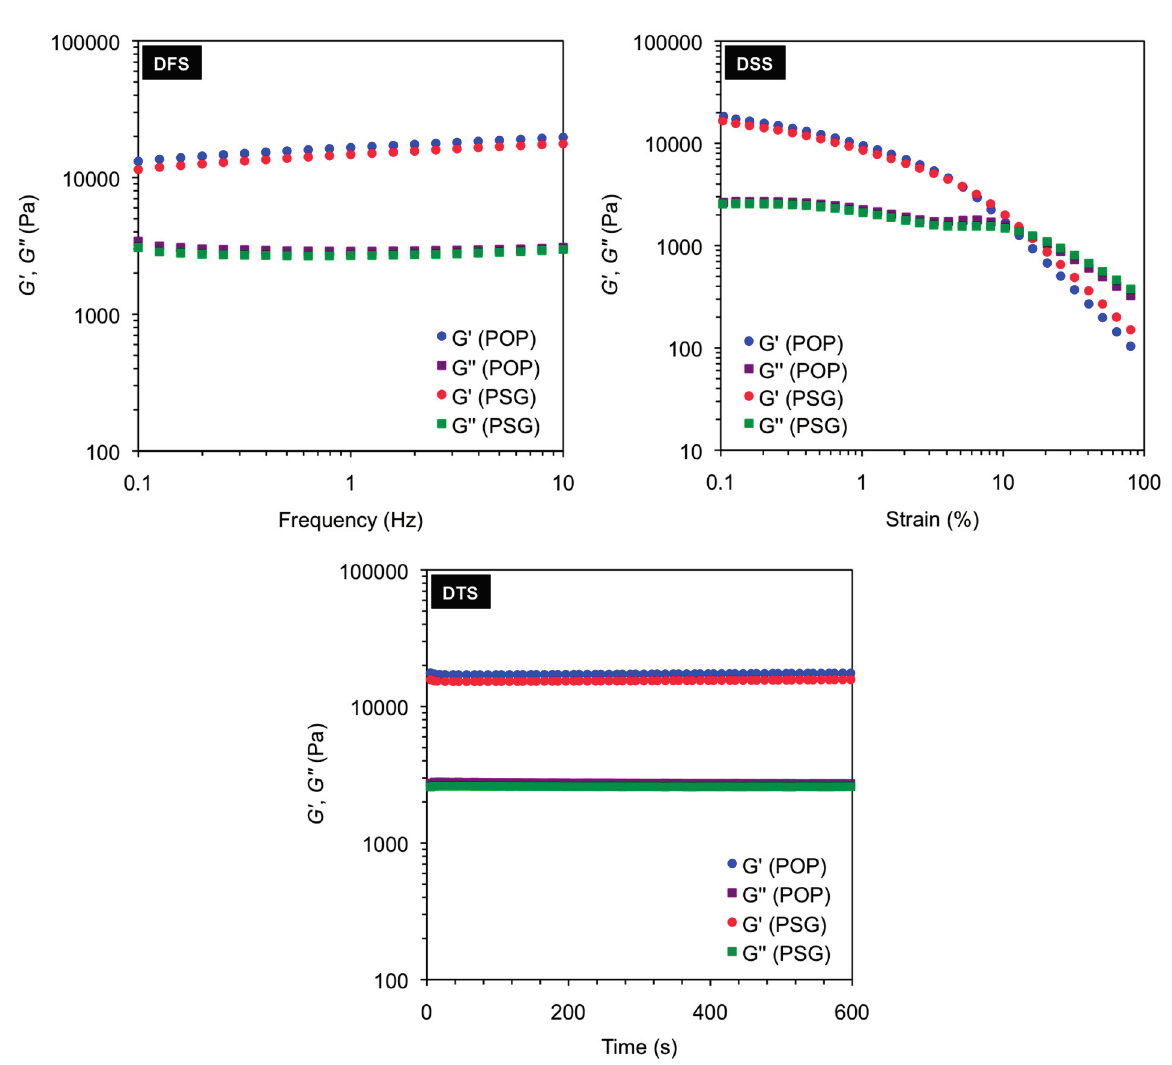
Figure 2. Dynamic oscillatory rheological measurements ( i.e. , DFS, DSS, DTS) of the gels in toluene obtained after gelation of pure organic phase (POP) and phase selective gelation (PSG) of toluene/water mixture (1:2 v / v ) using A4 as gelator (2.0% w / v ). Heating-cooling treatment was used in these examples to induce gelation. Average storage modulus G' (16.5 ± 1.97 kPa for POP; 14.7 ± 1.89 kPa for PSG), average loss modulus G'' (3.0 ± 0.12 kPa for POP; 2.8 ± 0.11 kPa for PSG), average tan δ (0.18 ± 0.0028 for POP; 0.19 ± 0.0019 for PSG), and maximum strain at break (16% ± 2.0% for POP; 13% ± 1.5% for PSG) remained constant within the limits of the experimental error regardless the material. As observed in POP, the gels obtained from PSG displayed G' at least one order of magnitude higher than G'' and relatively low dependence with frequency, indicating the viscoelastic nature of the samples as well as a good tolerance to external